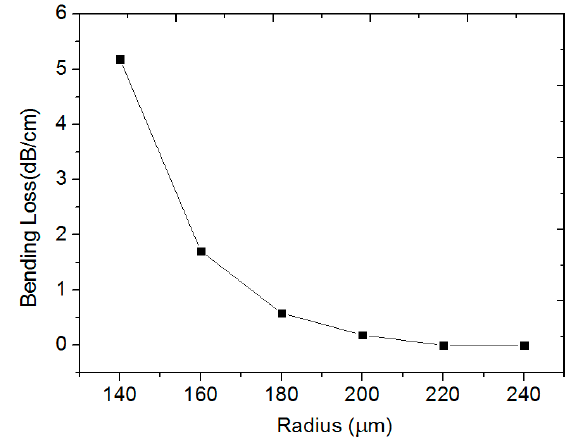
Figure 2. The relationship between bend loss and the radius of the microring.